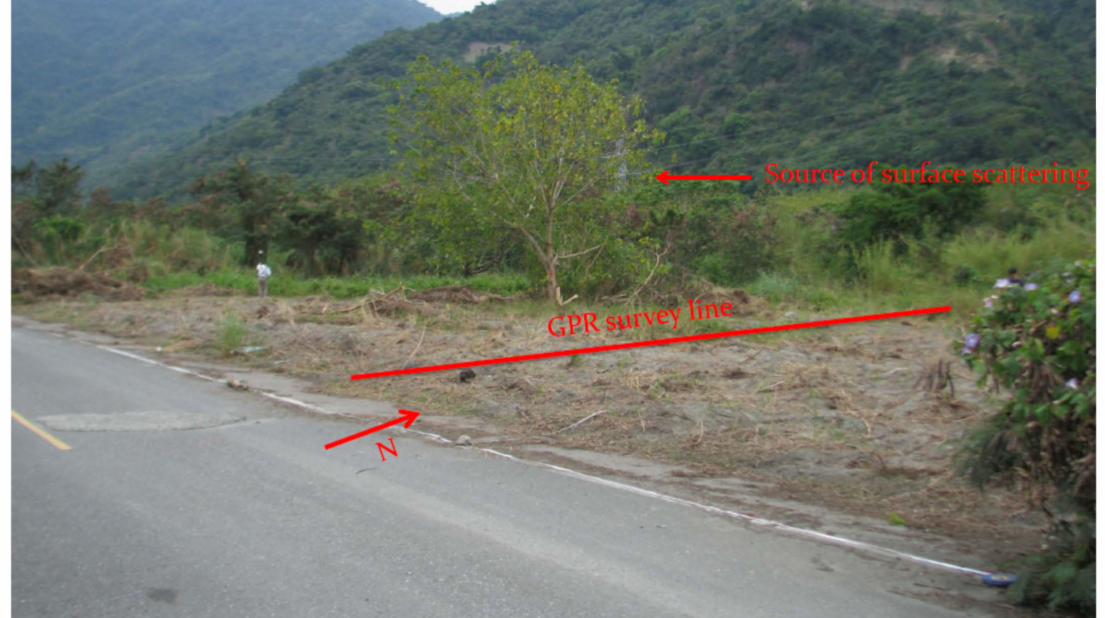
Figure 9. Landscape of the GPR survey site inundated by debris flow earlier. There were 16 survey lines deployed on the debris flow-covered surface. The thick red line indicates the location of the survey line selected for this